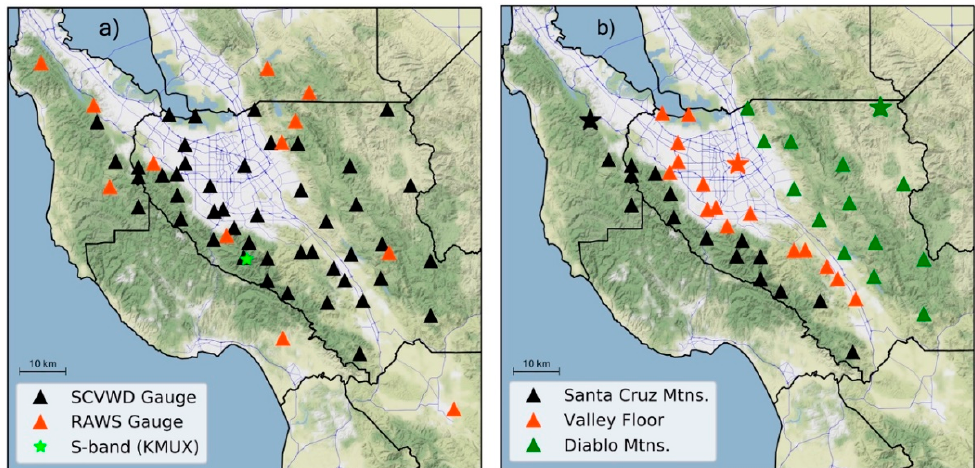
Figure 2. Station locations within the model domain: ( a ) Remote Automated Weather Stations (RAWS) gauges are used to perform quality control on Multi-Radar Multi-Sensor (MRMS) grids. Santa Clara Valley Water District (SCVWD) gauges are used for model analysis. Location of KMUX central to the domain provides the entire domain with high quality radar measurements; ( b ) SCVWD stations as categorized by zone. Stars represent locations used for radar time-height cross-sections. Black star = Huddart Park, red star = San Jose, green star = Biel Ranch.